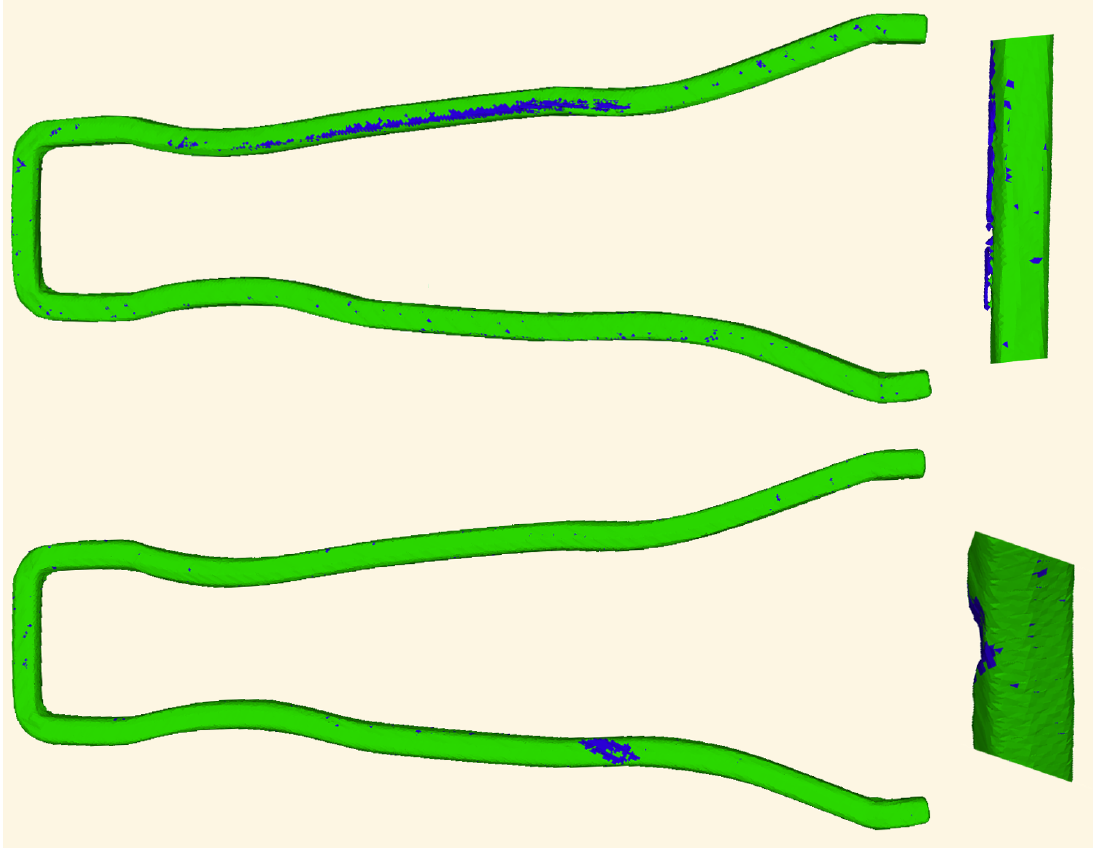
Figure 10. Top image: typical correct object incorrectly classified by SSM. Bottom image: typical defective object not detected by KH